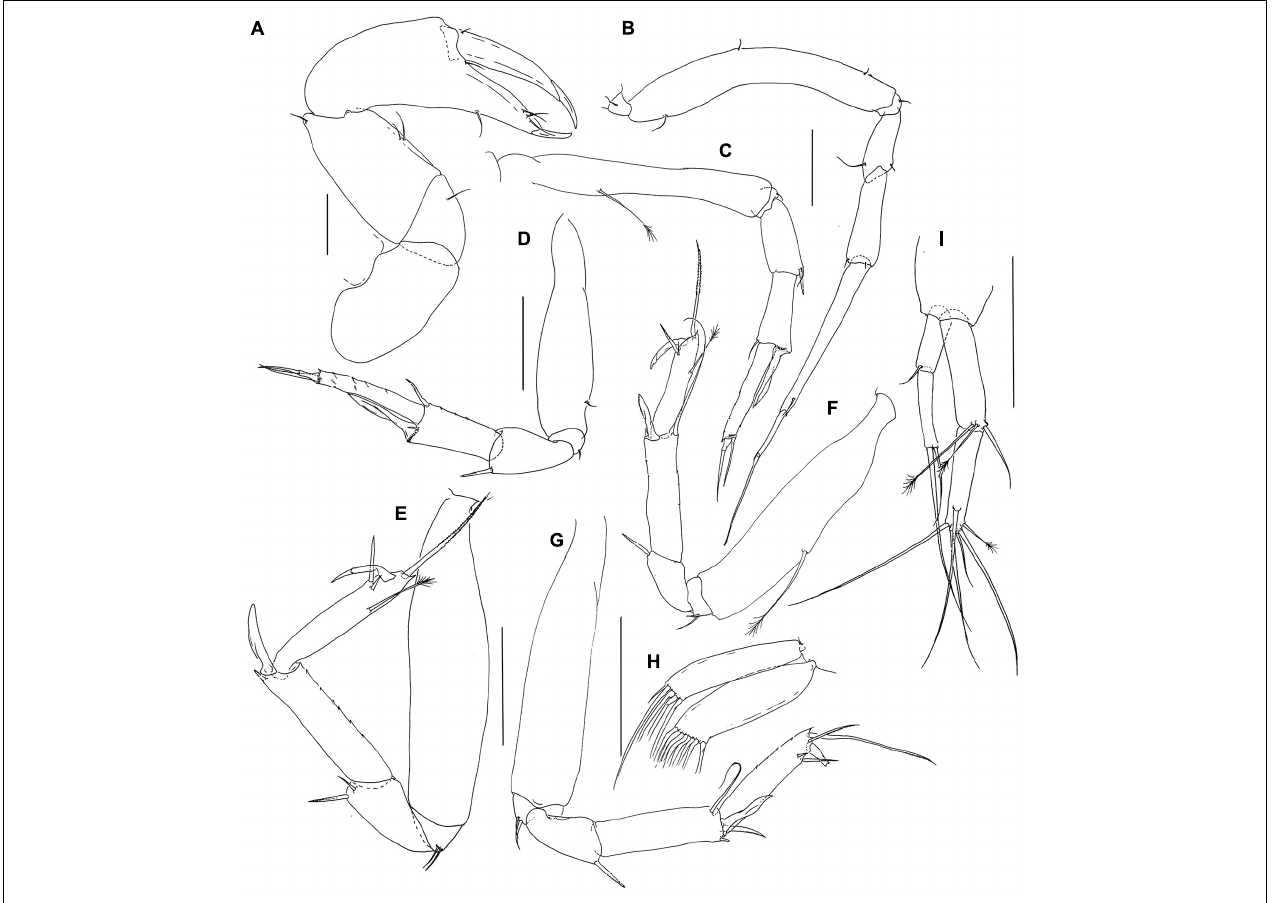
FIGURE 3 | Pseudotanais chardonnayi sp. nov.; neuter (J61515), (A) , cheliped; (B) , pereopod-1; (C) , pereopod-2, (D) , pereopod-3; (E) , pereopod-4; (F) , pereopod-5; (G) , pereopod-6; (H) , pleopod; (I) , uropod. Scale lines = 0.1